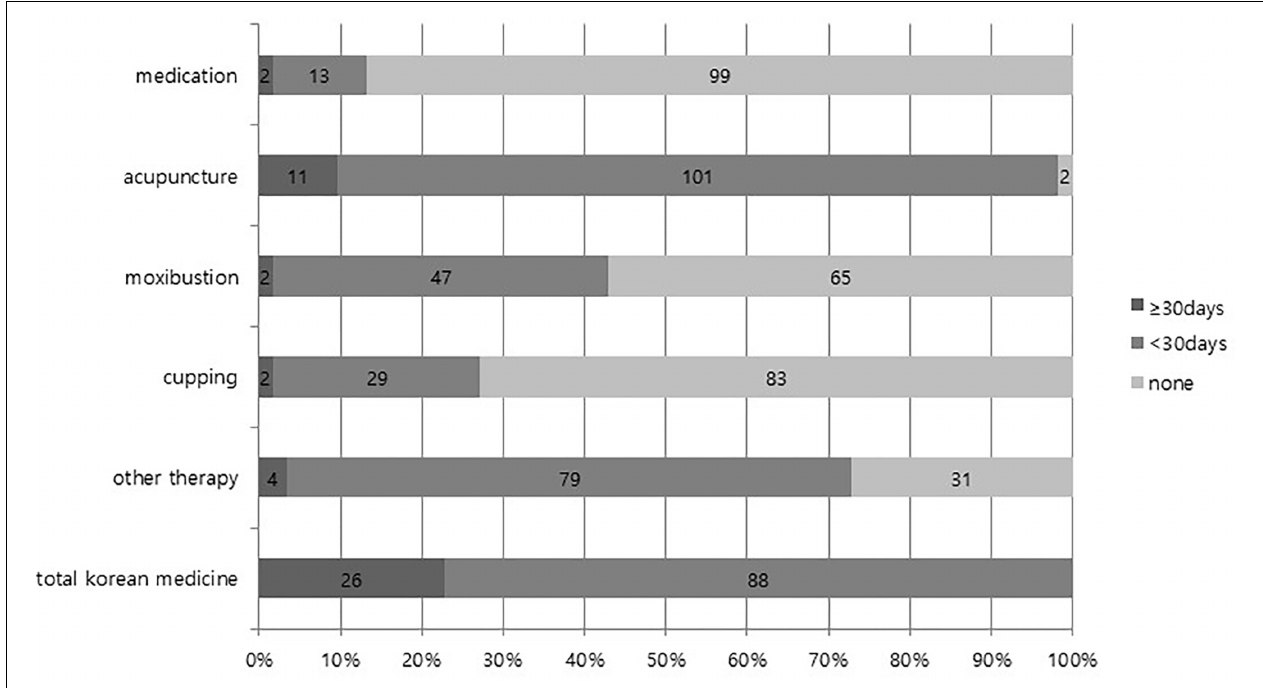
FIGURE 3 | Status of KM therapy in integrative therapy